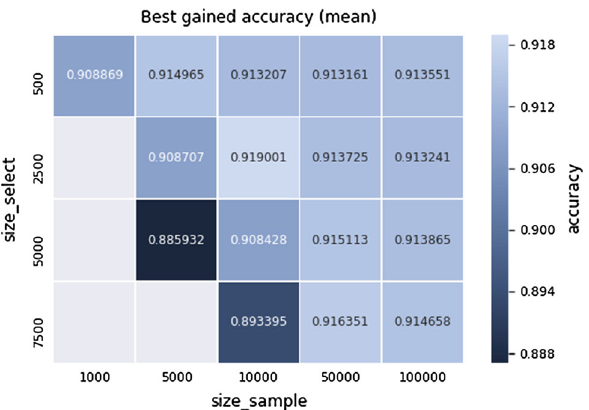
Fig. 8 Thedependenceoftheaccuracyinthelastiterationoftheactive learning procedure on the number of candidates in each iteration. The error bars indicate the range within which the accuracies over 7 runs lie. As described in the text, an optimum value can be observed, although it should be noted that this value also depends on the number of data points selected in each iteration